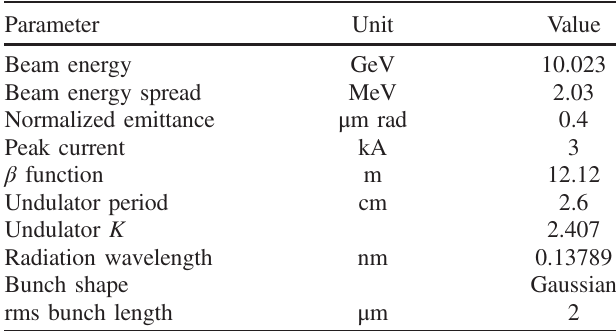
TABLE III. 3D FEL simulation